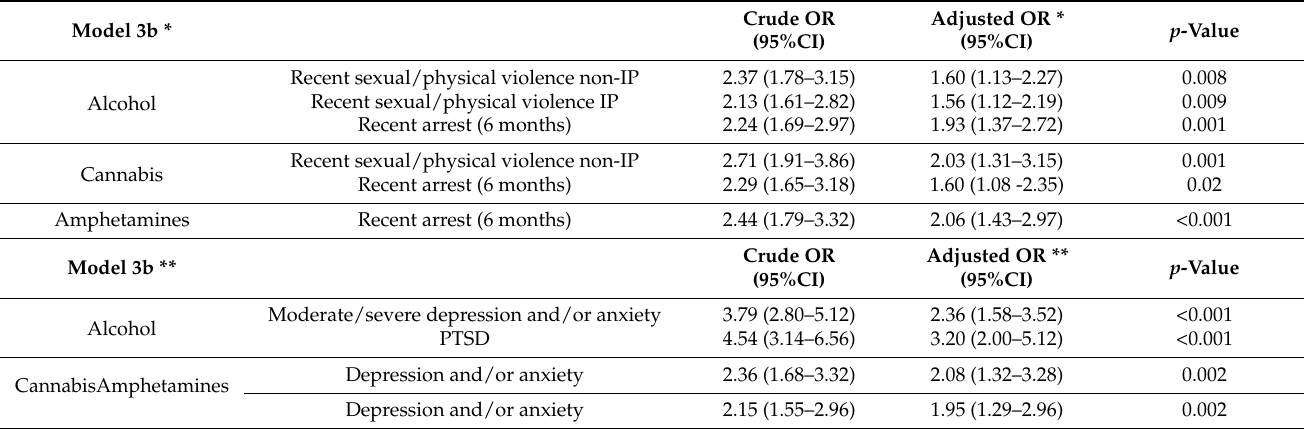
Table 4. Multivariable logistic regression: associations with alcohol/substance use and level 3a and b